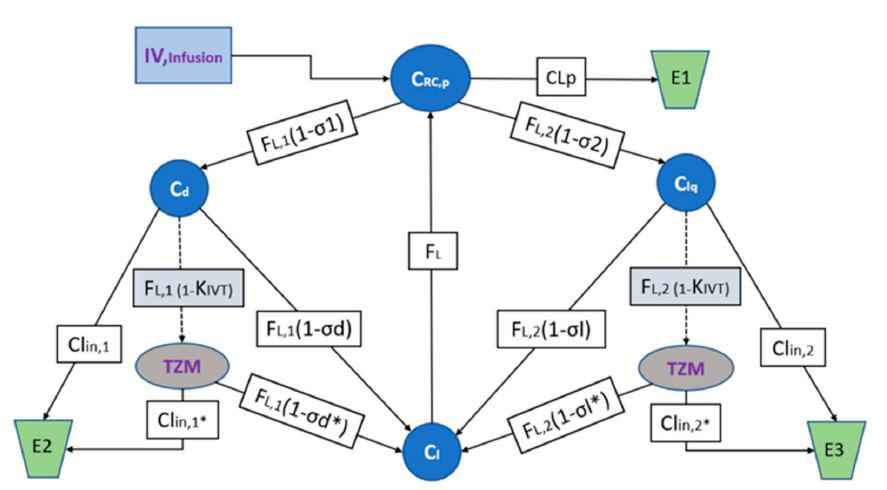
Figure 8. Model structure of the PBPK TZM mRNA IVT for the plasma baseline concentrations. Whereas C RC,P is the mAb mRNA TZM concentration found in plasma volume V P , C d and C lq are the mAb concentrations in ISF in the tissues dense and leaky of volumes V d and V lq and of continuous, and fenestrated capillaries, respectively, V l is the lymph volume and assumed almost equal to blood volume. The F L is the total lymph flow which is considered equal to the sum of F L,1 and F L,2 being the lymph flux for V d and V lq respectively. The σ d and σ l and the σ d ∗ and σ l ∗ being the coefficients of vascular reflection V d and V lq for the mRNA formulation and the correspondent TZM IgG, respectively. The CL P , CL in,1 , CL in,1 ∗ and CL in,2 , CL in,2 ∗ are the clearances for the plasma and ISF dense, leaky tissues for the mRNA formulation and the correspondent TZM IgG,